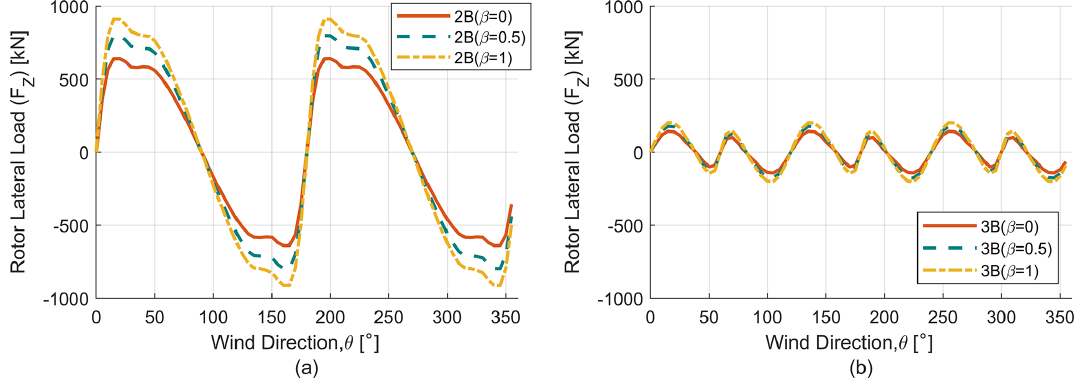
Figure 13. Parked lateral load ( F Z ) analysis. (a) Parked lateral load ( F Z ) for two-bladed (2B) rotors. (b) Parked lateral load ( F Z ) for three-bladed (3B)